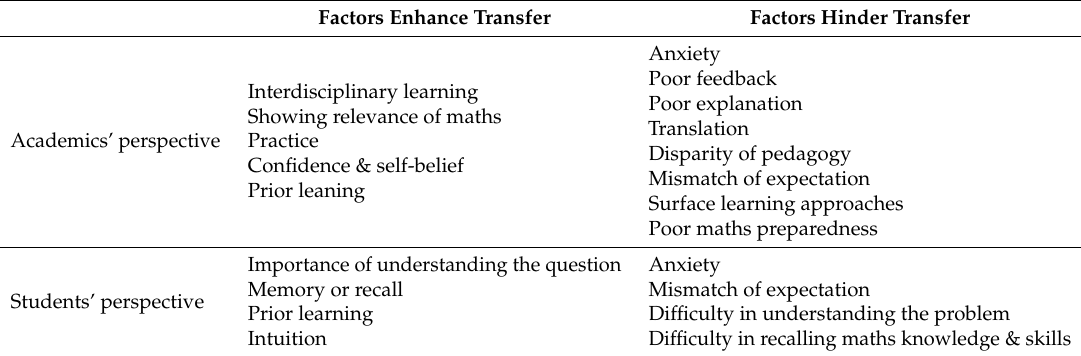
Table 3. Potential factors promoting or hindering